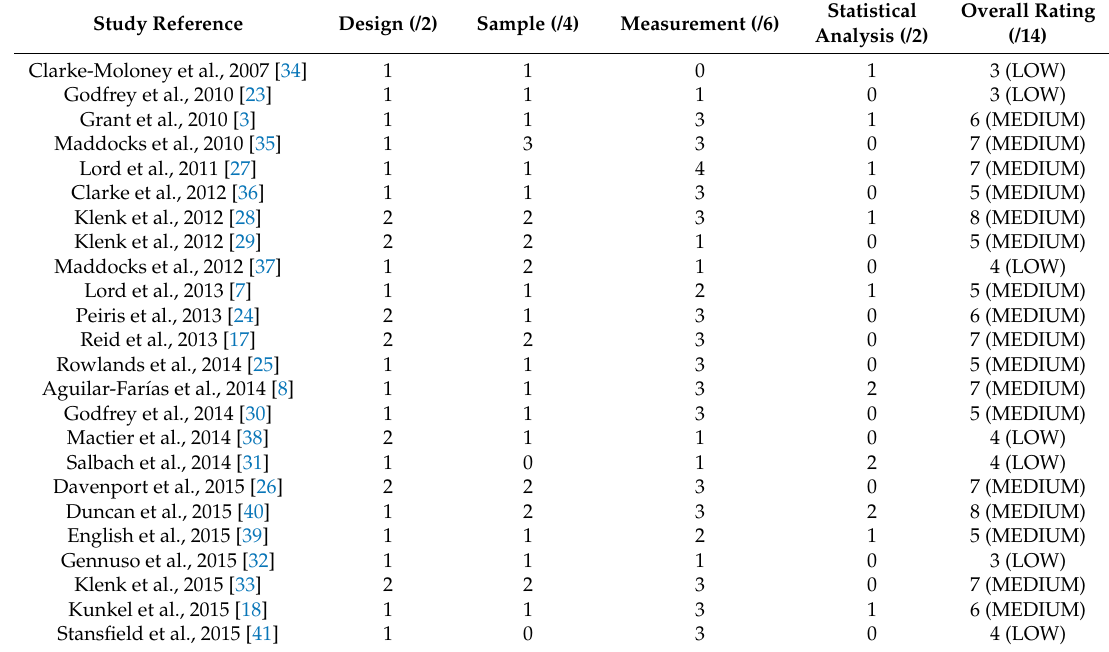
Table 2. Quality assessment domain and overall ratings for observational